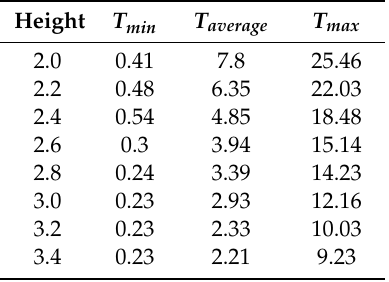
Table 2. The waiting time (in days) information corresponding to di ff erent wave heights (2–3.4 m).